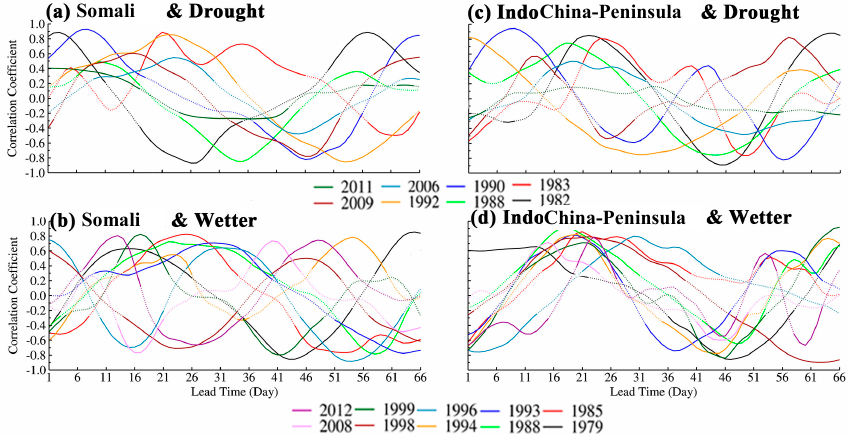
Figure 12. Evolution of lagged correlation coefficients between two indices of geographical water vapor transport (WVT) anomalies and SPI1 during: ( a , c ) drought; and ( b , d ) wetter processes. Solid and dotted line segments correspond to passing and failing Student’s t test, respectively.